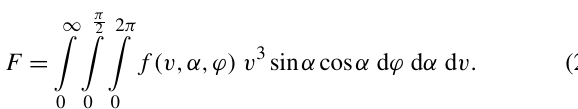
Figure 5. Magnetic field magnitude at the sheet edges as a function of y 1 for three values of the sheet widths y 0 (anti-parallel case).